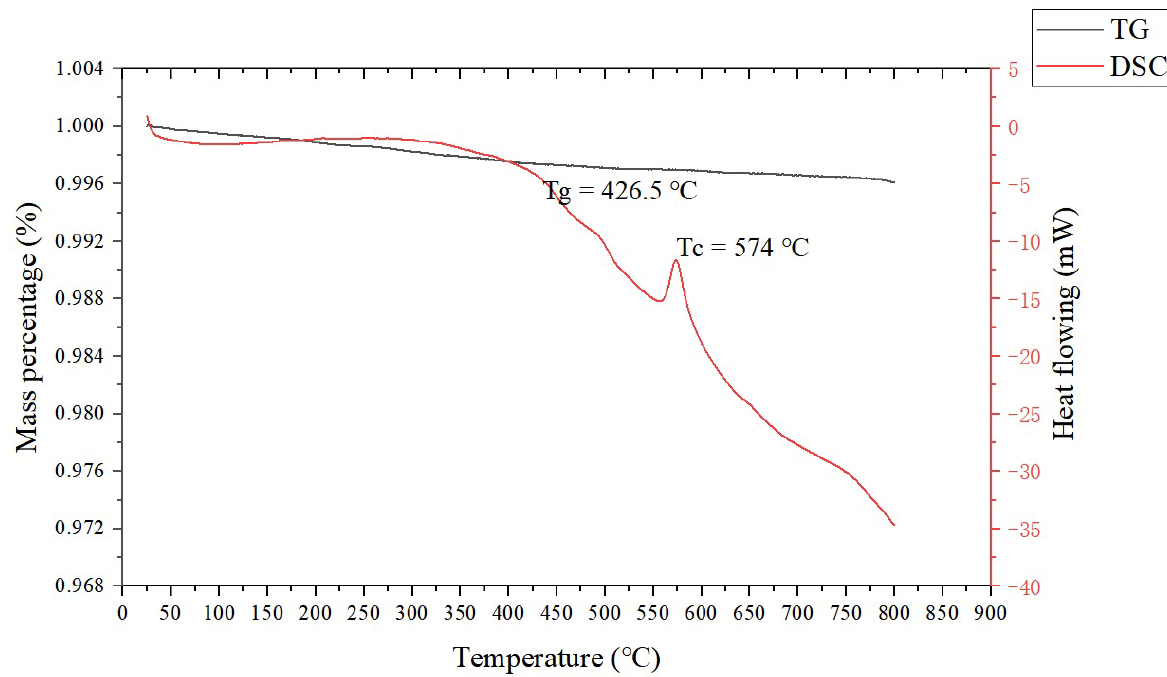
Figure 2. DSC chart of the glass powder.